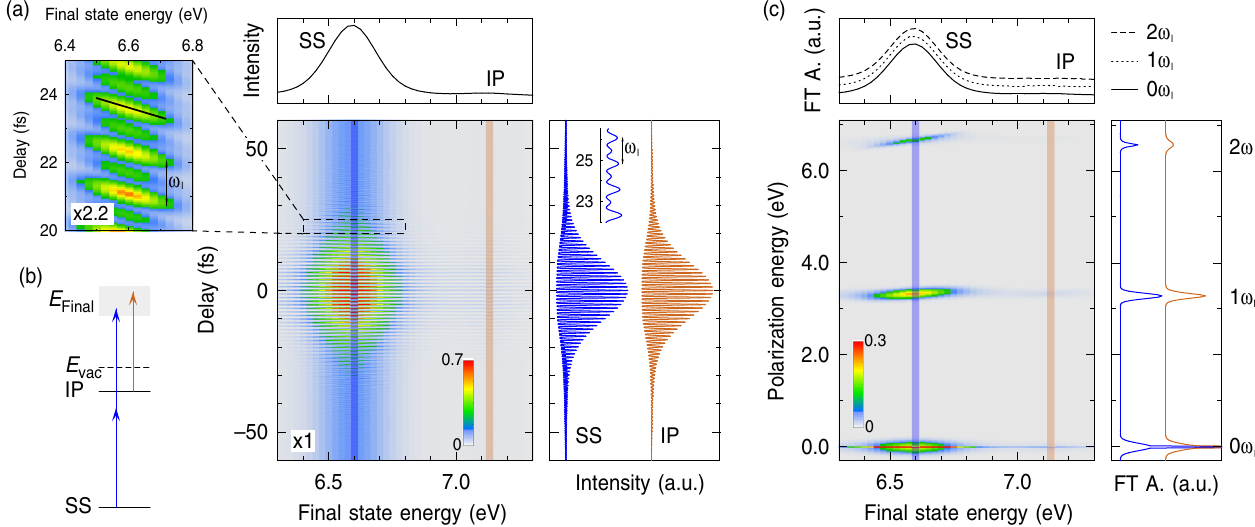
FIG. 3. (a) OBE simulation of an energy- and phase-resolved ITR-2PP measurement for the three-level system shown in (b), which consists of the occupied initial state (SS), unoccupied intermediate state (IP), and final state continuum ( E E (gray box). The center plot in (a) shows the calculated ITR-2PP measurement, specifically the population of the final state (color vac coded) as a function of the energy and pump-probe delay. Top: The calculated final state energy spectrum consisting of the SS and IP states is a profile through the ITR-2PP data at t ¼ 0 fs. Right: Interferometric two-pulse correlation traces are profiles through ITR-2PP for the energies of SS and IP states; oscillations caused by interferences at the driving laser frequency 1 ω l and its second harmonic 2 ω l are expanded in the inset. The color-coded expanded inset of ITR-2PP shows interference fringes tilting towards t ¼ 0 fs with an increasing final state energy (highlighted by the black line at approximately 24 fs). (c) 2D-FT photoelectron spectra obtained by Fourier transformation of the time axis in (a). The polarization energies (the Fourier axis) induced in the sample at 0 ω l , 1 ω l , and 2 ω l are correlated with the final state energies at which the photoemission process terminates. Top: Normalized Fourier filtered 2PP spectra at 0 ω 1 ω 2 ω l , l , and l (top to bottom). Right: Line profiles taken at the SS and the IP state energies showing FT amplitudes of the and 2 ω l